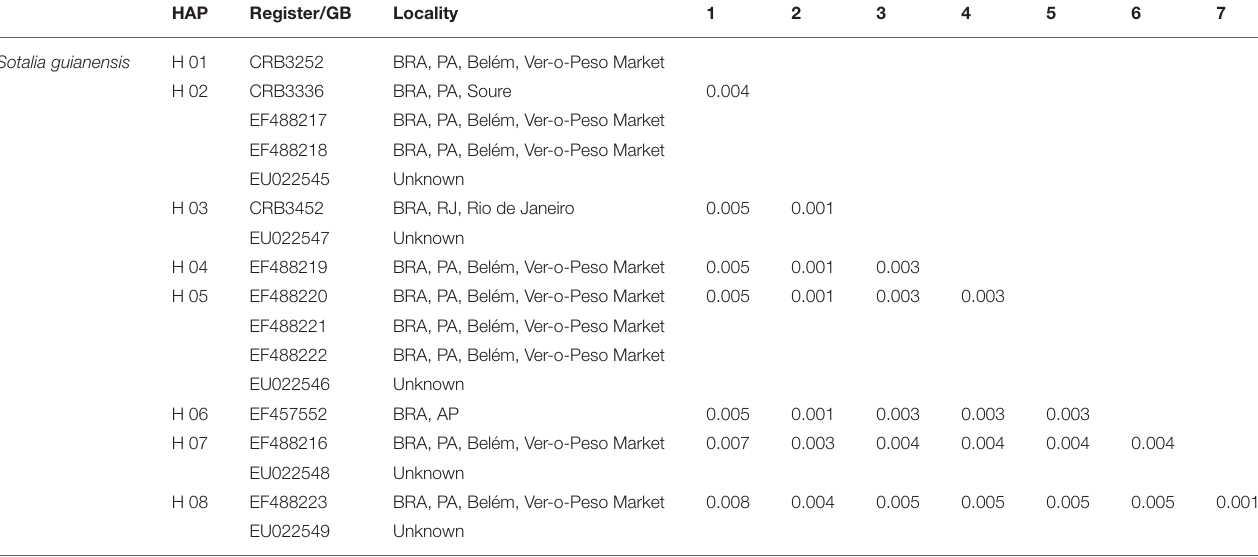
TABLE 2 | Kimura 2 parameter genetic distance estimates for Sotalia guianensis . HAP Register/GB